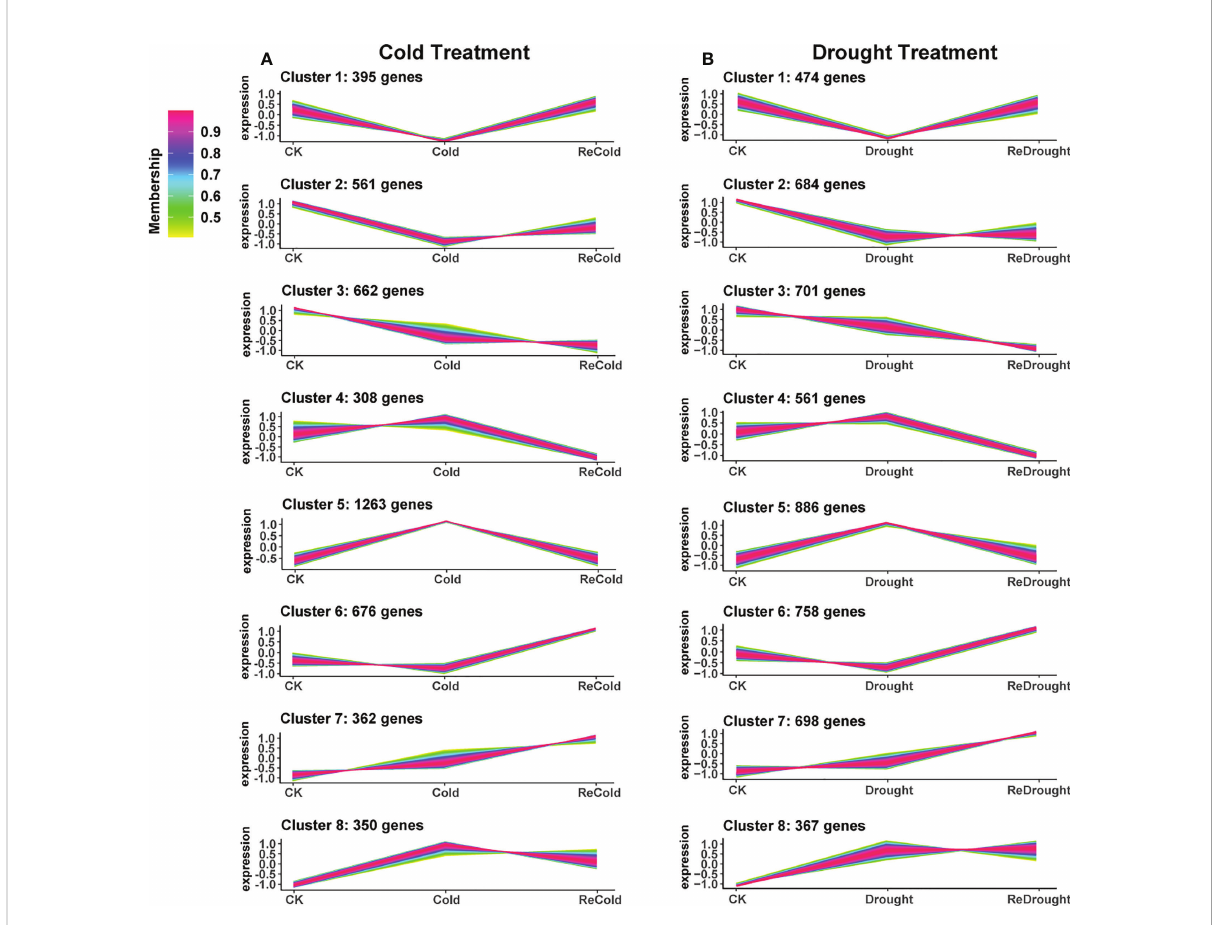
FIGURE 5 The expression patterns of differentially expressed genes. (A) Cold stress. (B) Drought stress. The vertical axis represents the relative level of the gene, and the line color represents the model fi